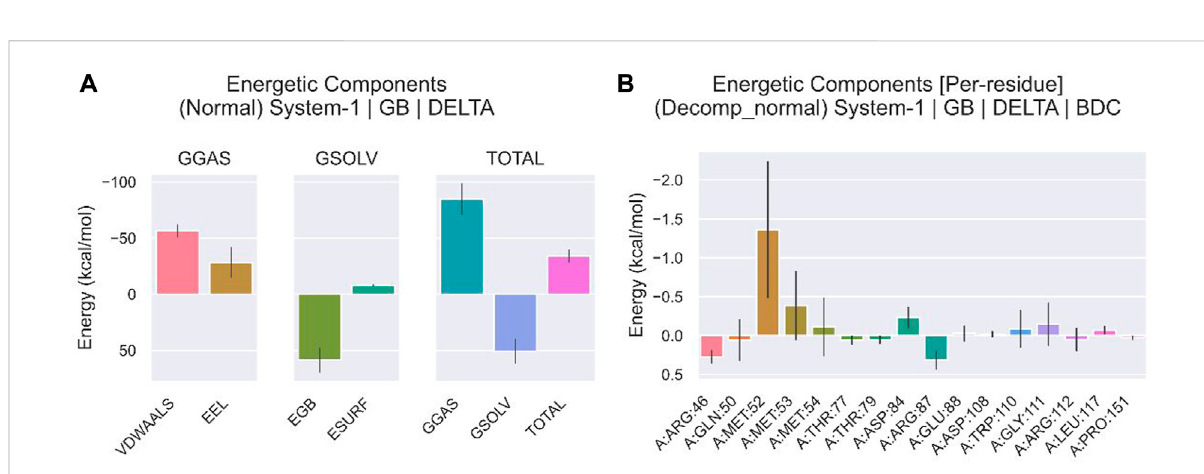
FIGURE 9 Energyanalysisofmoleculardynamicssimulations. (A) Bindingfreeenergyofprotein – ligandcomplexes.VDWAALS,vanderWaalsenergy;EEL, electrostaticenergy;EGB,polarsolvationenergy;ESURF,non-polarsolvationenergy; GGAS,totalgasphasefreeenergy; GSOLV,totalsolvationfree energy; G total free energy = GSOLV + GGAS. (B) The relationship between each contact residue and the binding